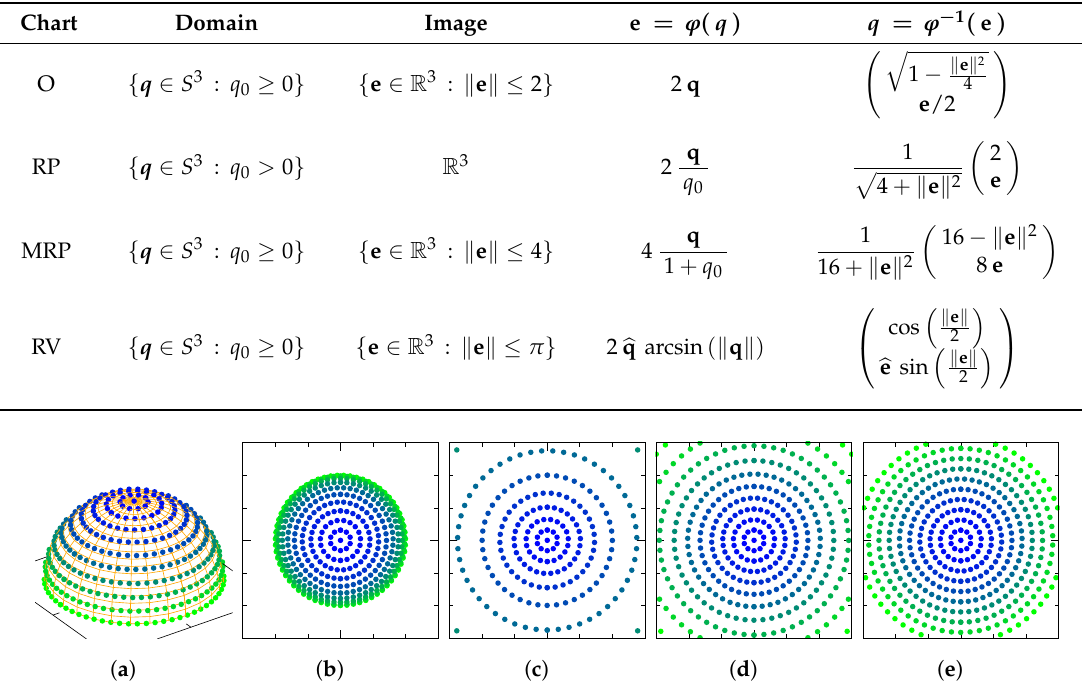
Figure 1. Points in the manifold with q 3 = 0 are mapped with points in the Euclidean space through